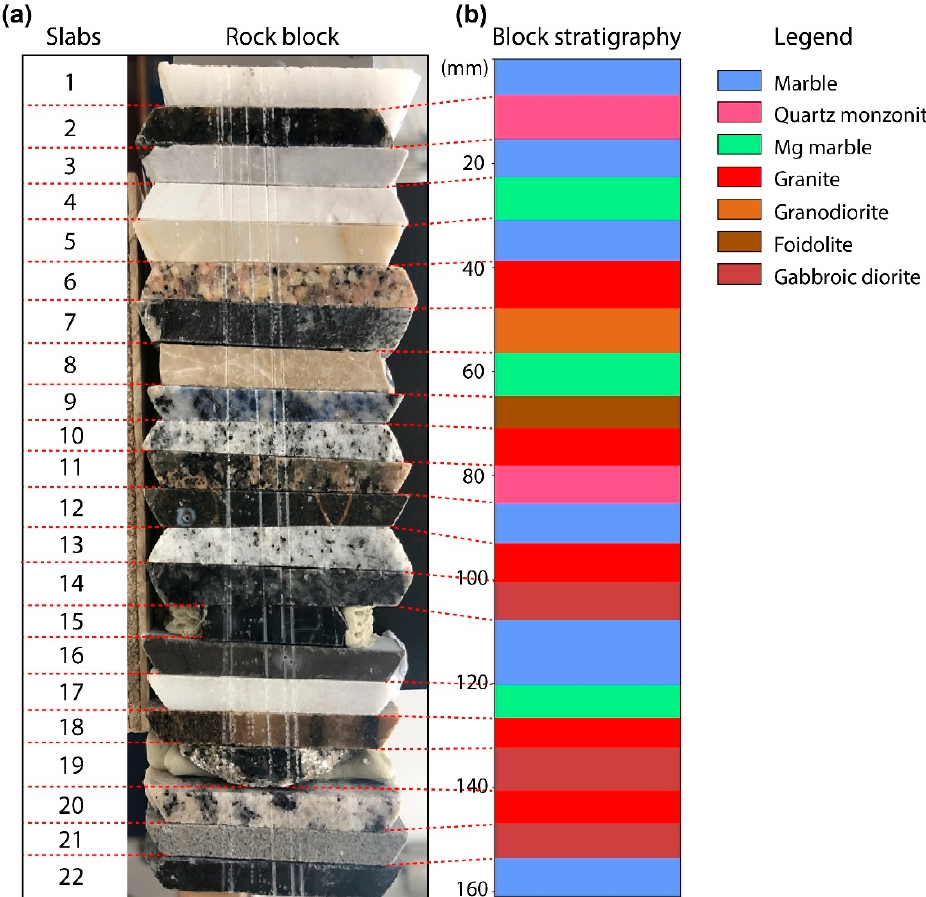
Figure 2. Rock block assembled for this study. ( a ) Rock block of approximately 16 cm length, composed of 22 distinct rock slabs; ( b ) lithogeochemical log of the rock block. Lithologies assigned according to CaO-MgO-Fe 2 O 3 (for marbles) and total alkali versus silica (for igneous plutonic rocks) discrimination diagrams and using whole-rock geochemical data.